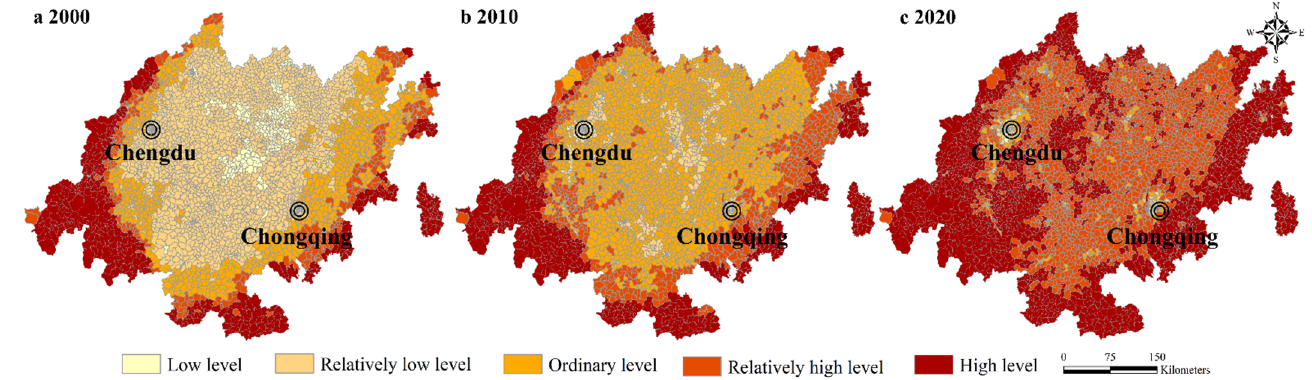
Figure 4. Spatial distribution pattern of NPP in CUA in 2000, 2010, and 2020.